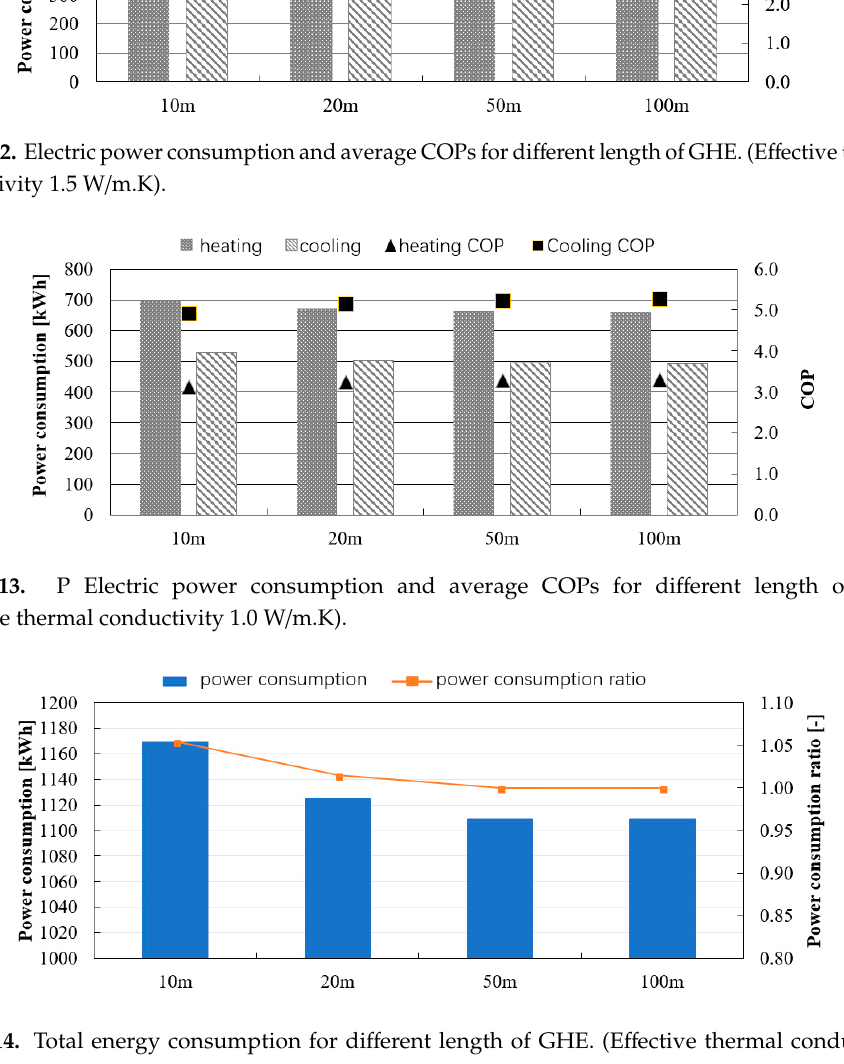
Figure 14. Total energy consumption for di ff erent length of GHE. (E ff ective thermal conductivity 1.5 W /